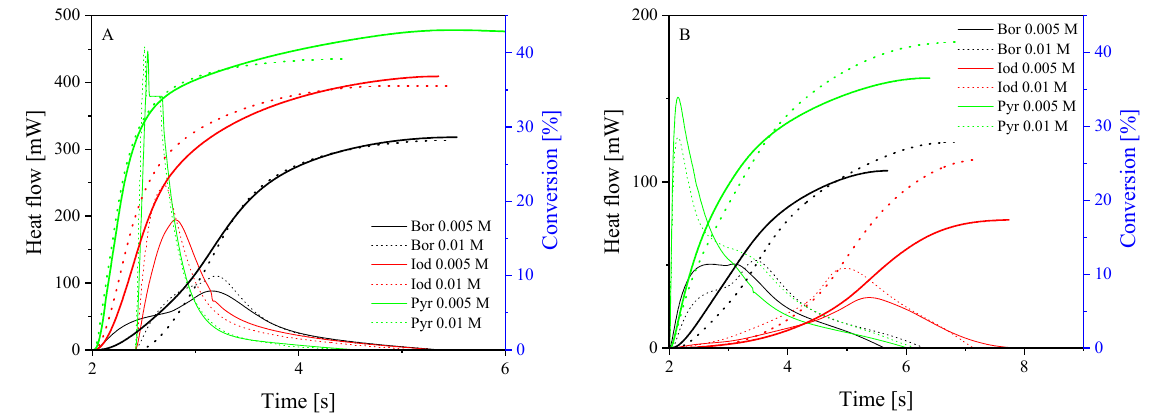
Figure 6. The photopolymerization profils of TMPTA in a presence of ( A ) 1/Bor, 1/Iod, 1/Pyr and ( B ) 5/Bor, 5/Iod and 5/Pyr under irradiation with OmniCure 2000S at different photoinitiating system concentrations (photosensitizer concentration 1 × 10 − 3 M). Light intensity: 50 mW cm − 2 (solid line denotes data of rate of polymerization; dash line–conversion of monomer).